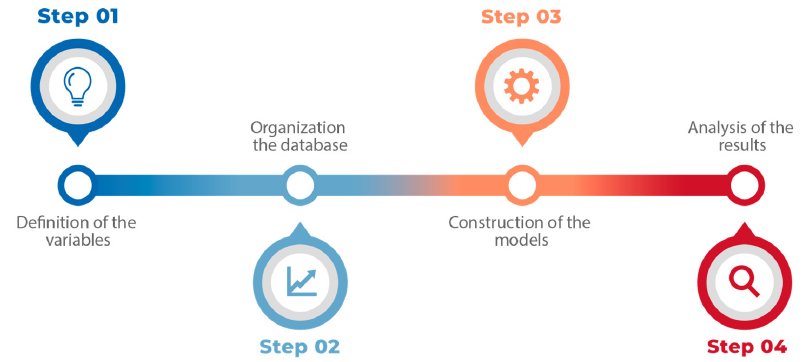
Figure 2. Principal steps of the method.